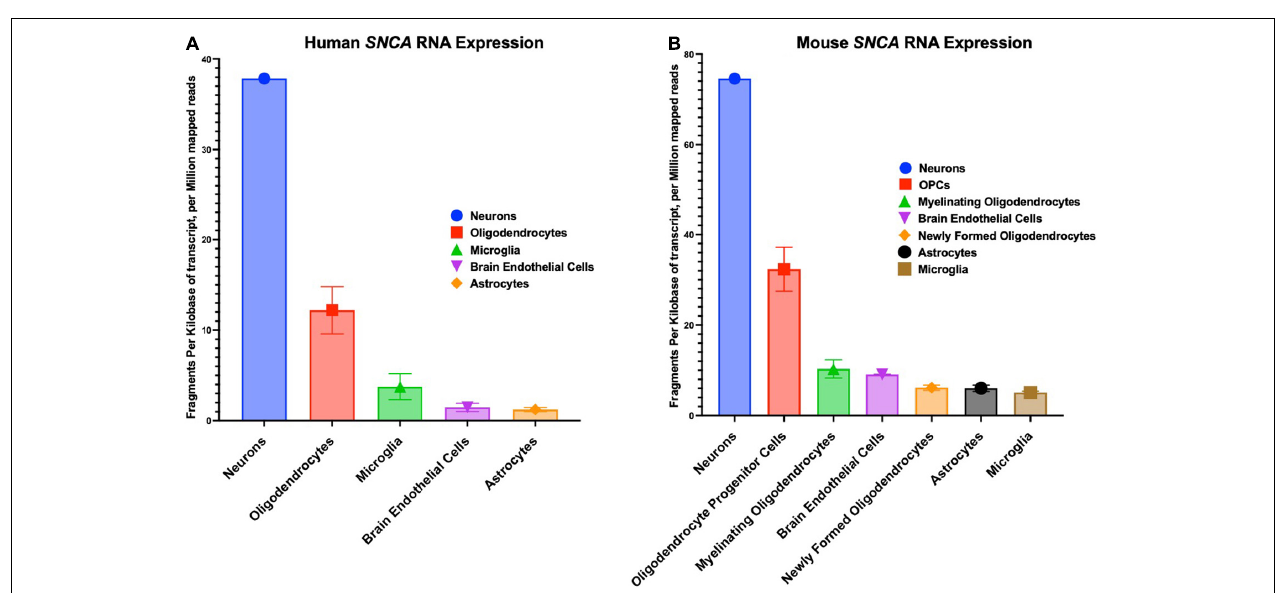
FIGURE 1 | Schematic representation of relevant landmarks on the protein α -synuclein. The N-terminus is characterized by being amphipathic, containing mutations associated with familial PD, four of the seven KTKEGV repeats, and lipid-binding sites that induce the disordered structure to adopt an α -helical secondary structure when bound to lipid membranes. The central non-amyloid- β component (NAC) is hydrophobic and is the site where α -synuclein proteins interact with each other to form aggregates. The C-terminus is acidic and intrinsically disordered.